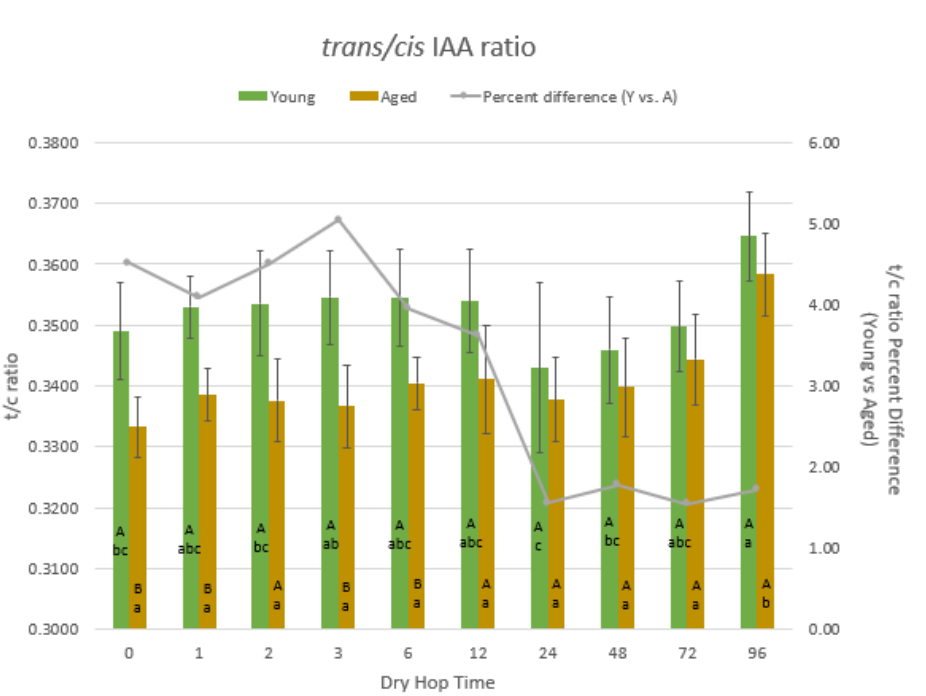
Figure 1. Comparison of the t / c ratios for each pair of Young and Aged treatments and the % t / c ratio loss during aging ( n = 9). Upper case letters = significance difference between Young and Aged beers with the same dry hop time. Lower case letters = significance difference between dry hop time within the same storage treatment.